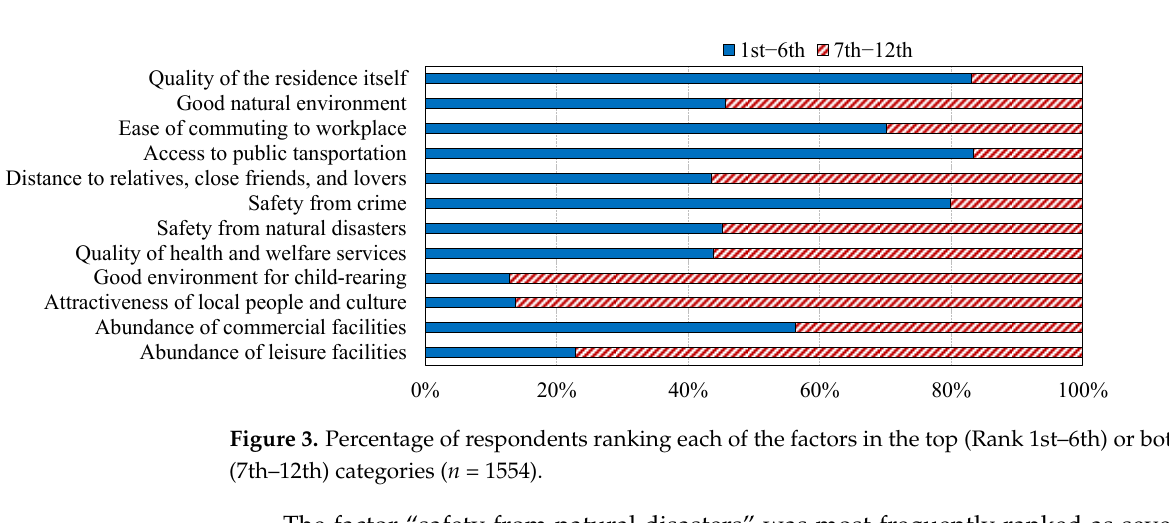
Figure 2. Ranking of factors influencing residential preferences amongst respondents ( n = 1554). A value of 1 indicates highest preference, and 12 the lowest.